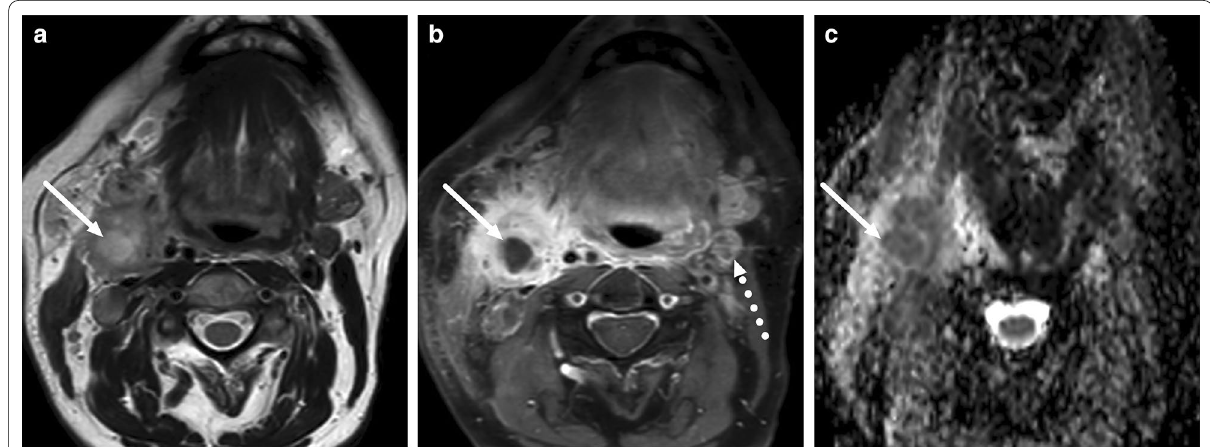
Fig. 32 Infected necrotic lymph node metastasis (arrows) from oropharyngeal cancer misdiagnosed as suppurative lymphadenitis on axial T2-weighted ( a ) and fat-suppressed post-contrast T1-weighed images ( b ) and ADC ( c ). The patient had signs and symptoms of an acute neck infection. Low ADC suggests that the non-enhancing fluid collection is purulent. The cancer was not known at the time of imaging. Note the necrotic lymph node without signs of infection on the contralateral side (dotted arrow in b ), suggestive of malignancy